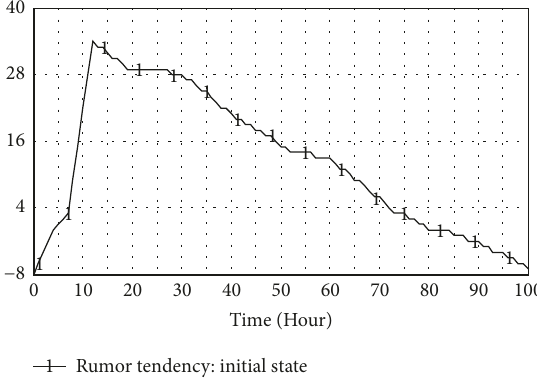
Figure 7: The rumor tendency